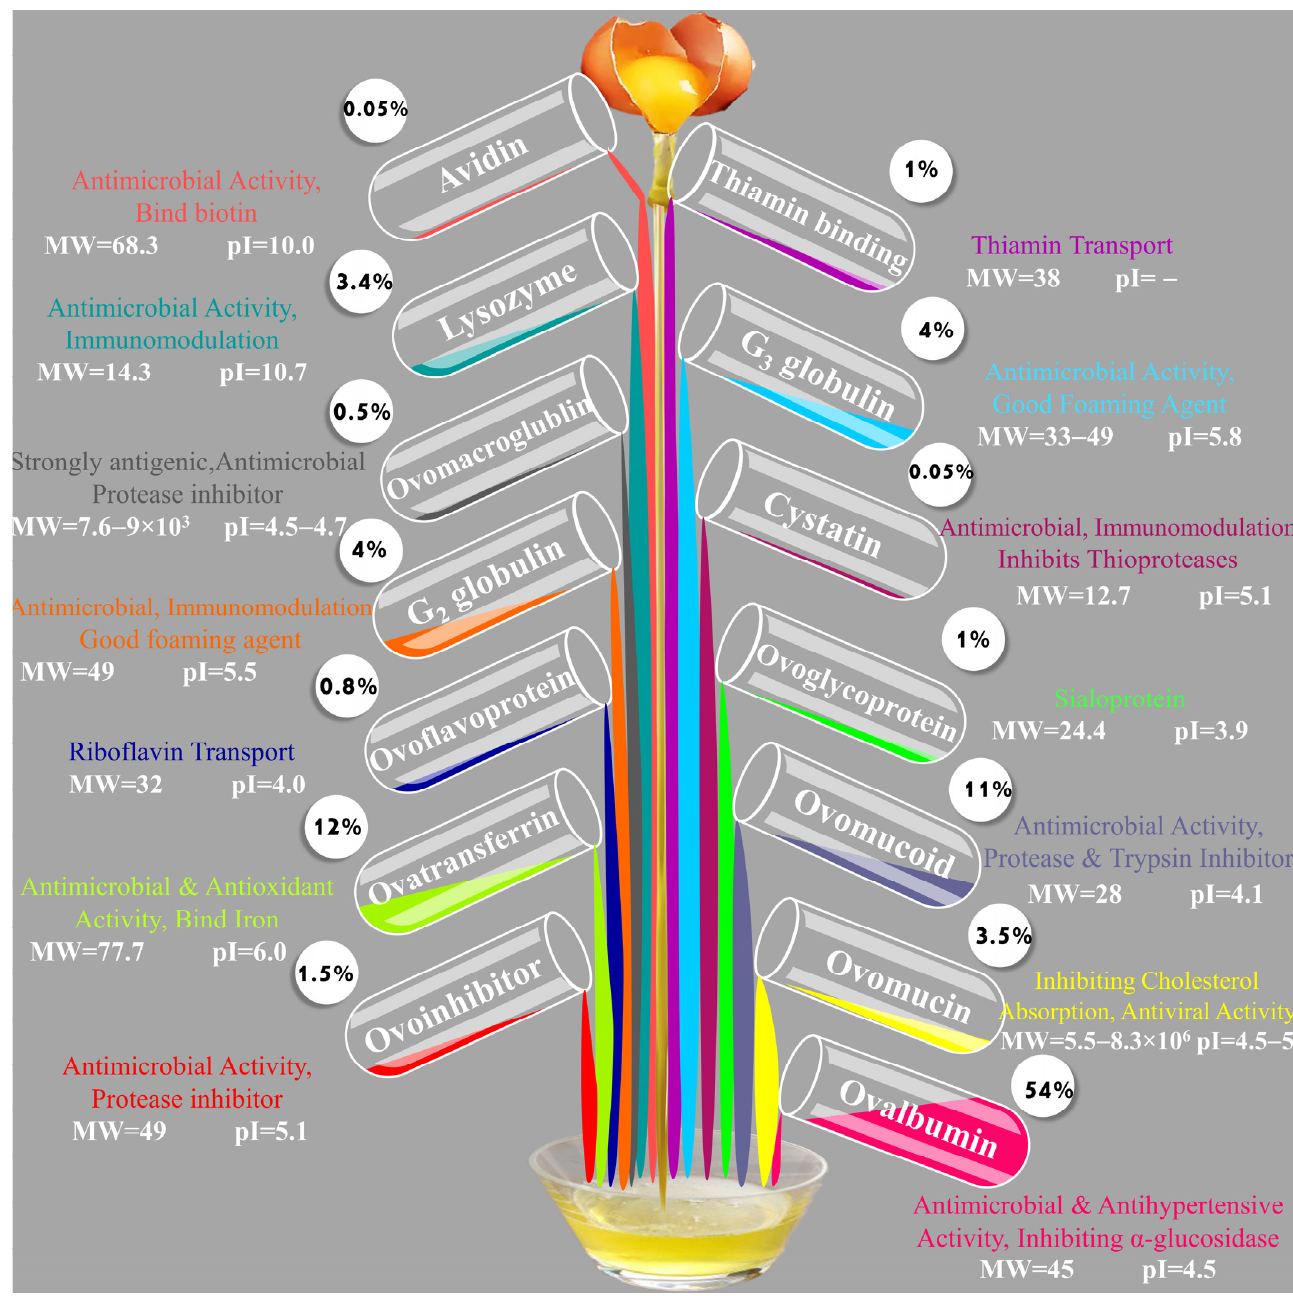
Figure 2. Percentage, Biological activity, molecular weight (MW), and isoelectric point (pI) of egg white proteins.